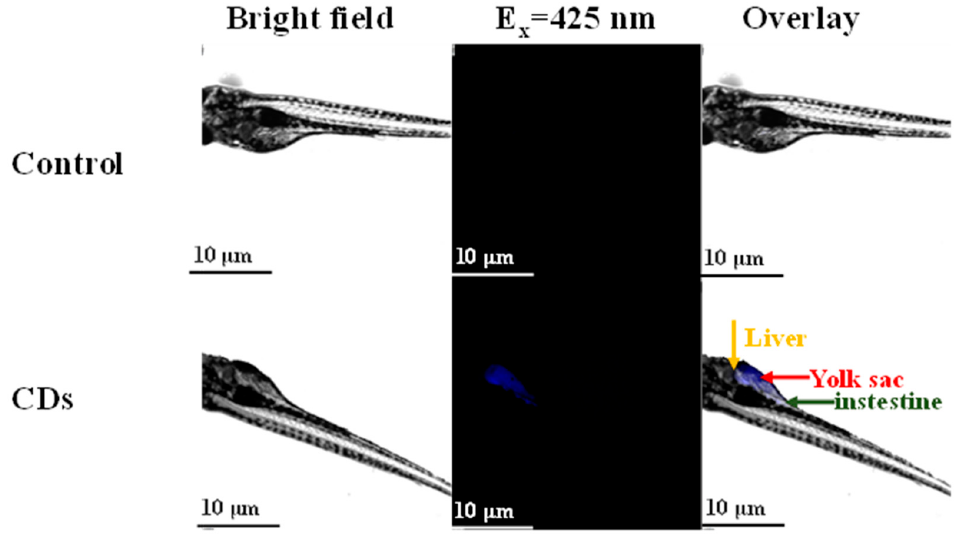
Figure 8. Bright field and fluorescence images of zebrafish larva incubated in 180-CDs for 48 h.